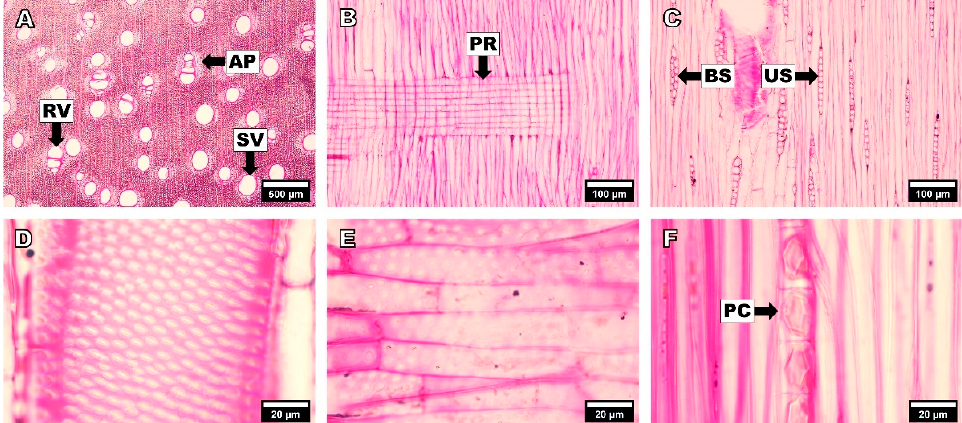
Figure 1. Optical micrographs of Acacia mangium . Cross-section ( A ), radial section ( B ), tangential section ( C ), intervessel pits ( D ), vessel-ray pits ( E ), and mineral inclusions ( F ). Solitary vessel (SV), radial multiple vessel (RV), axial parenchyma (AP), procumbent body ray (PR), uniseriate ray (US), biseriate ray (BS), and prismatic crystal (PC).